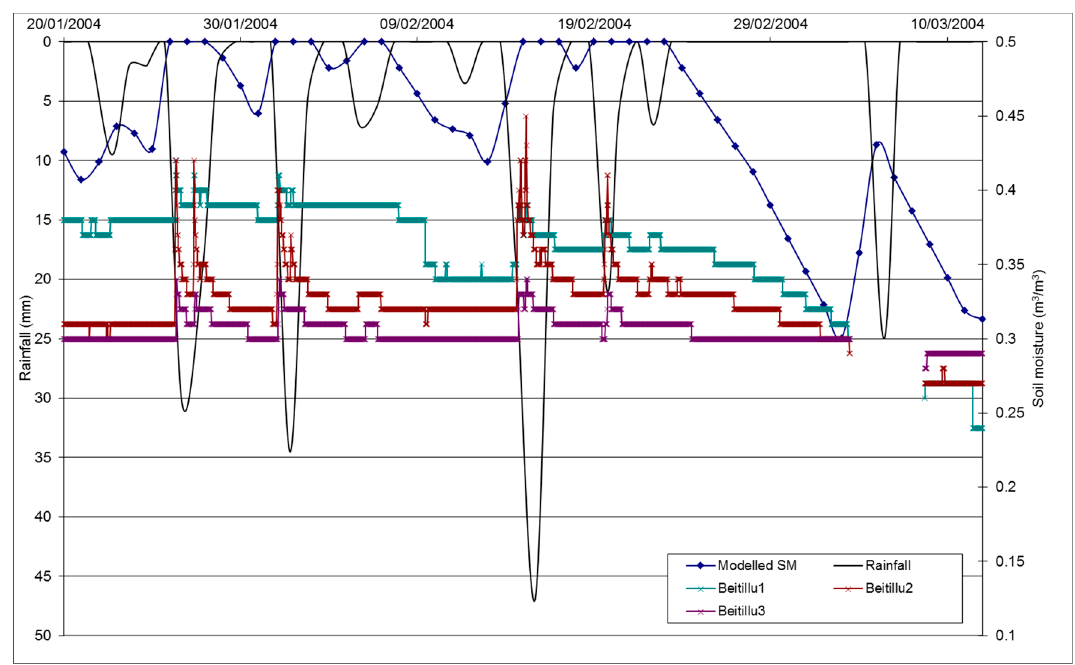
Figure 5. Comparison between modeled and observed soil moisture content for Beitillu (Winter 2003/04).